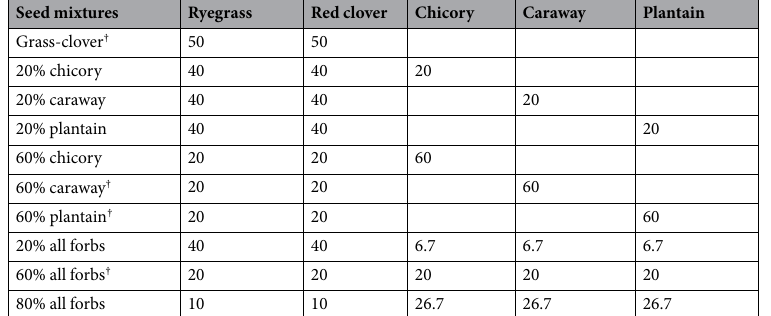
Table 1. Plant species and seed proportions in the 10 seed mixtures. Numbers in the table referes to the proportions (%) of optimal seeding rate of plant species in pure stands. † Four mixtures were selected for root